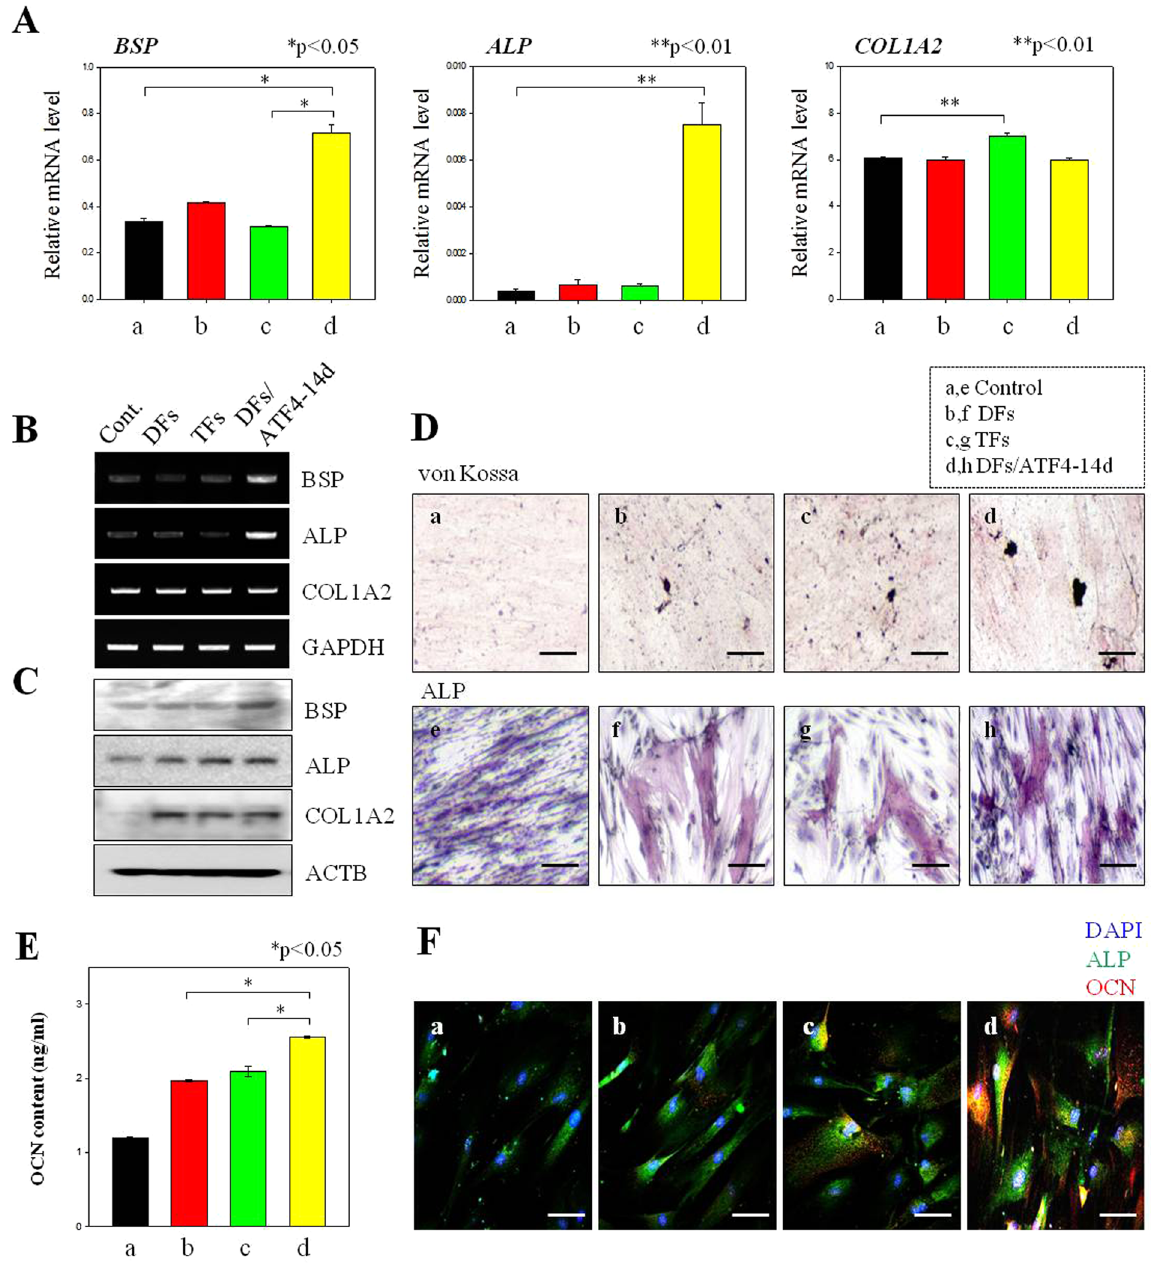
Figure 6. Osteogenesis of hMSCs transfected with two and three genes in a 2D culture system. ( A) mRNA expression levels of osteogenesis-related markers in hMSCs transfected with two and three genes. ( B ) Protein expression levels of osteogenesis-related markers in hMSCs transfected with one, two, and three genes. ( C ) Histological analysis of osteogenesis in hMSCs transfected with one, two, and three genes. ( D ) Quantified levels of OCN in hMSCs transfected with one, two, and three genes. * P < 0.05. ( E ) Immunofluorescence analysis of (a) control hMSCs and those transfected with (b) two genes, (c) all three genes at the same time point, and (d) ATF4 at 14 days after RUNX2/SP7 (blue, DAPI; green, ALP; and red, OCN). Scale bar, 100 μ